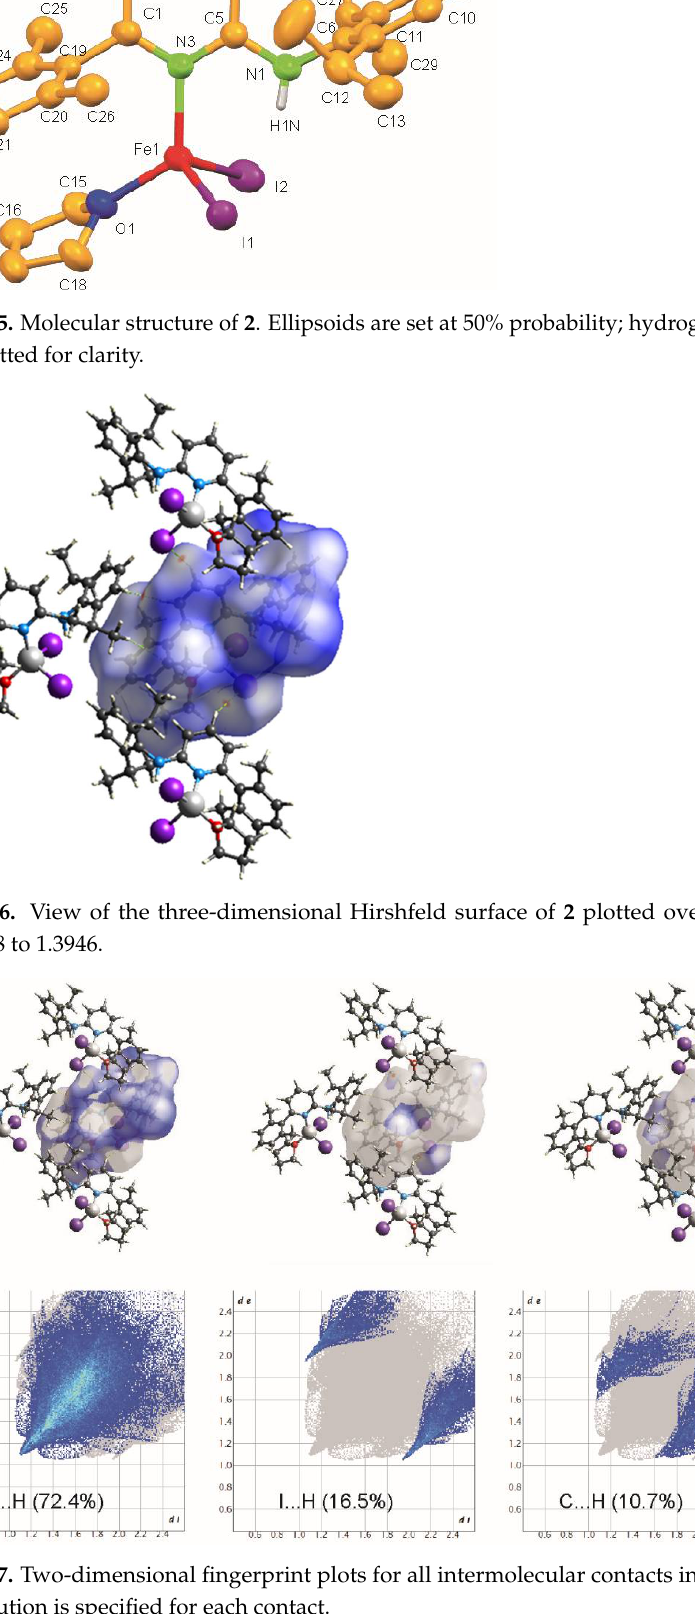
Figure 7. Two-dimensional fingerprint plots for all intermolecular contacts in 2 . The percentage of contribution is specified for each contact.